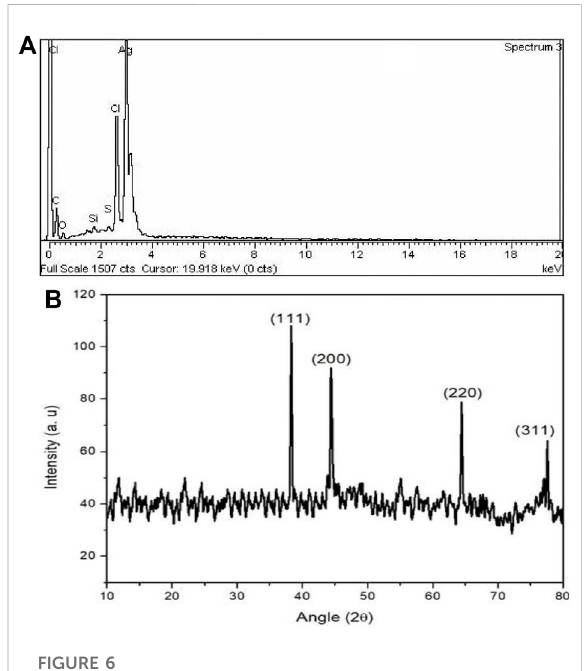
FIGURE 6 (A) Energy dispersive x-ray and (B) XRD pattern of the biosynthesized AgNPs.